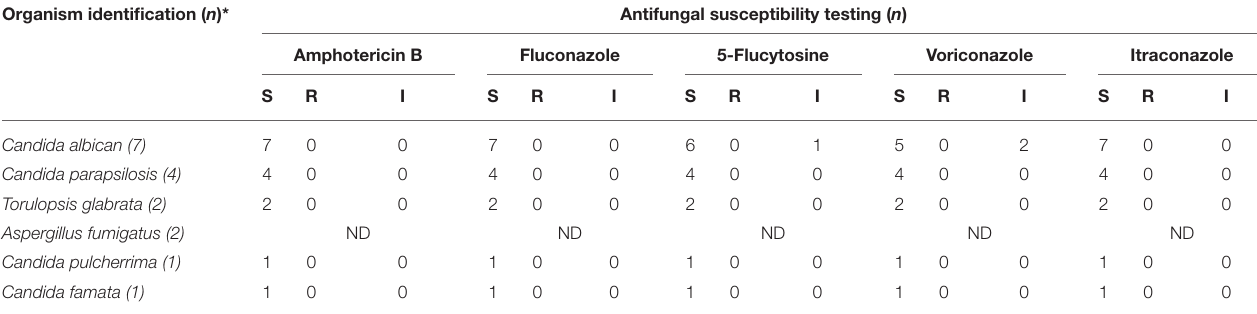
TABLE 2 | Results of susceptibility of isolates from 15 cases of fungal peritonitis. Organism identification ( n